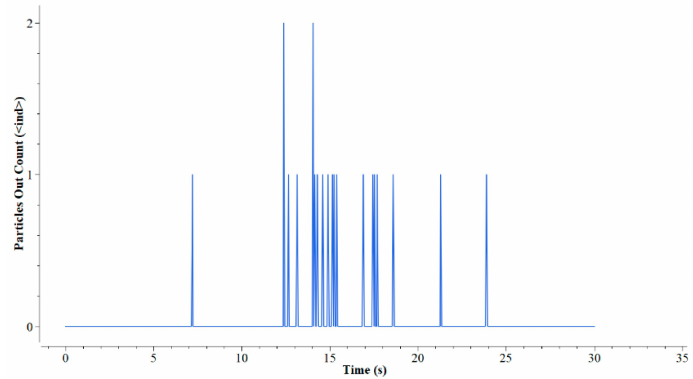
Figure 14. Collection of jujube branches on gear 3.